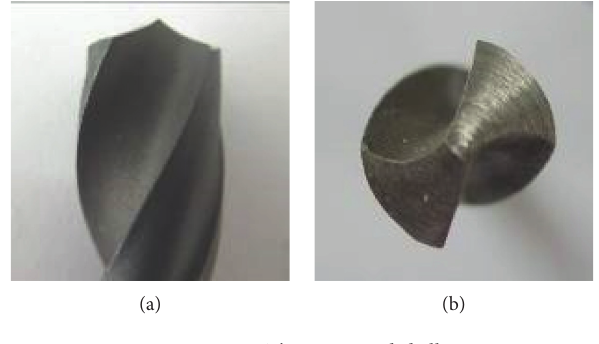
Figure 19: The improved drill.